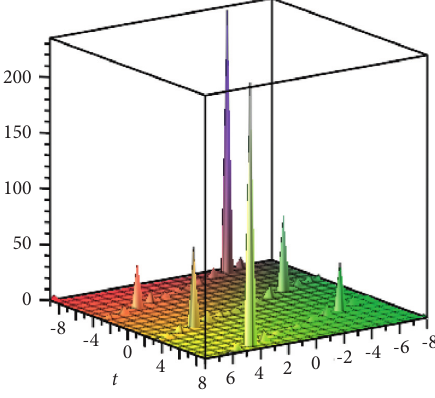
Figure 2: The periodic solution of | q � 0 . 2 , f � − 2 . 5, a � − 2 , within theinterval − 8 ≤ c � − 1 , k � 3 , a 1